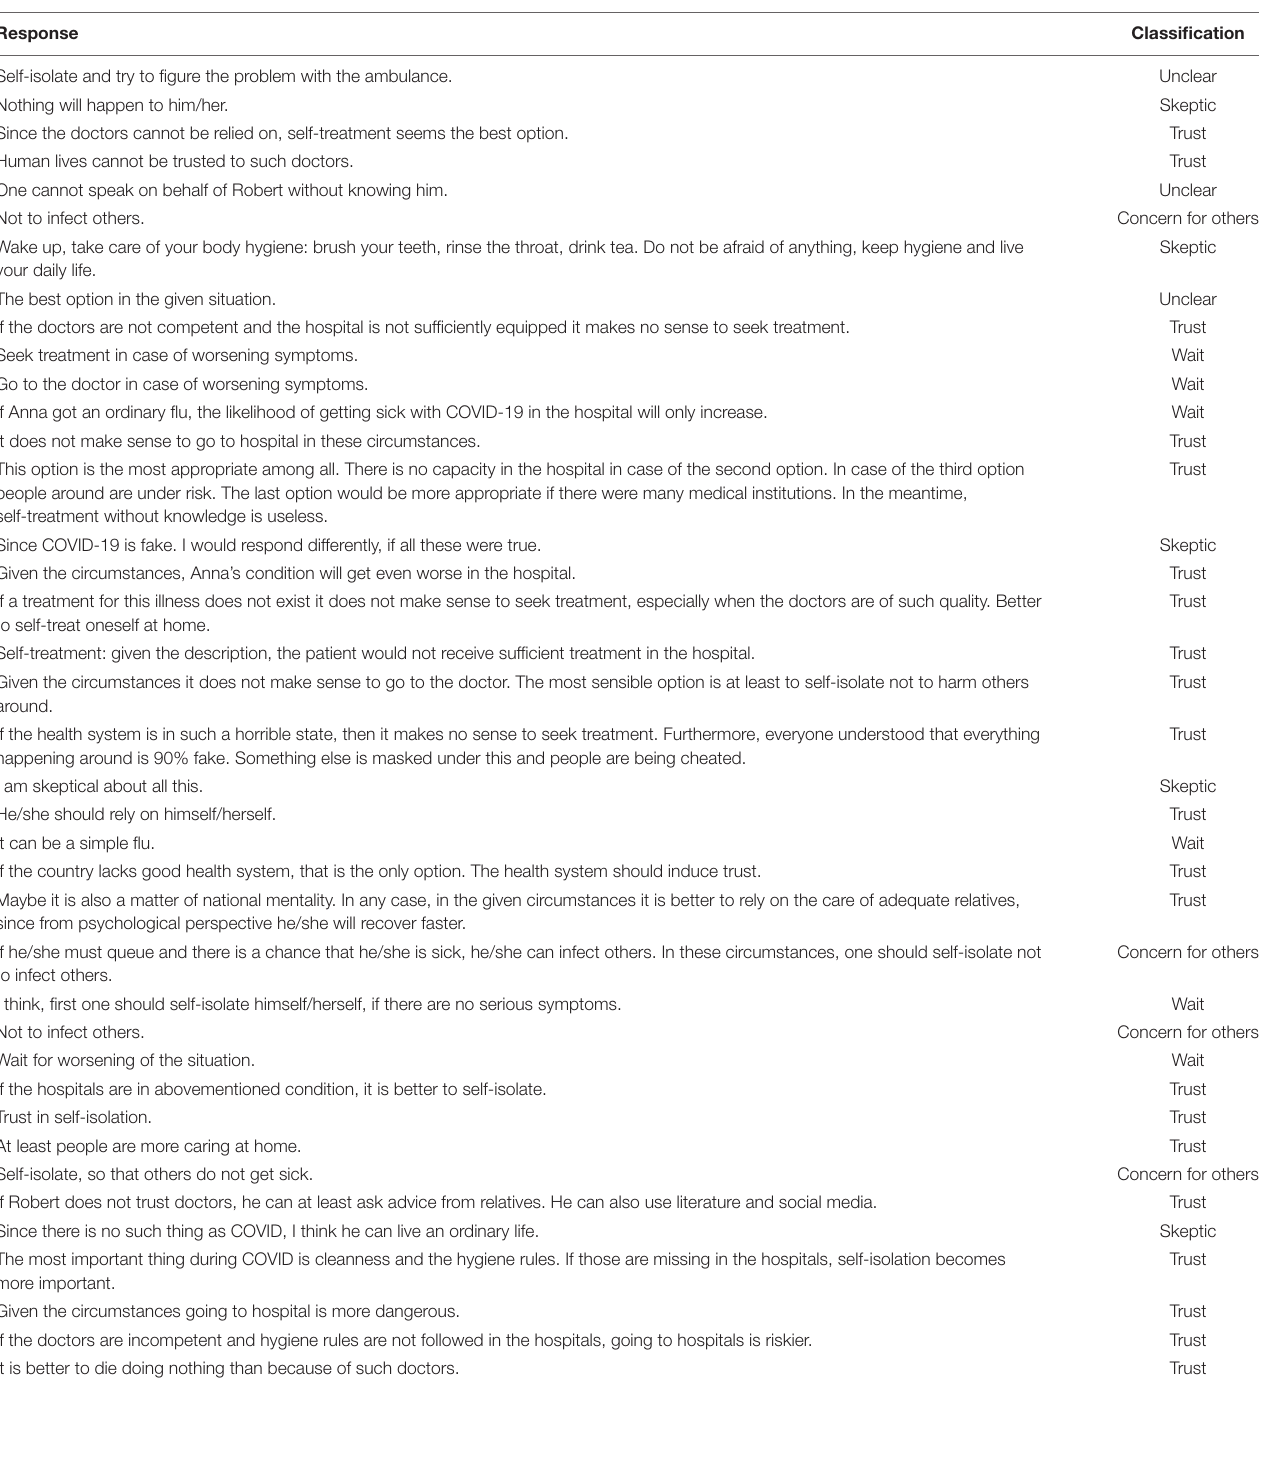
TABLE C1 | Classification of the